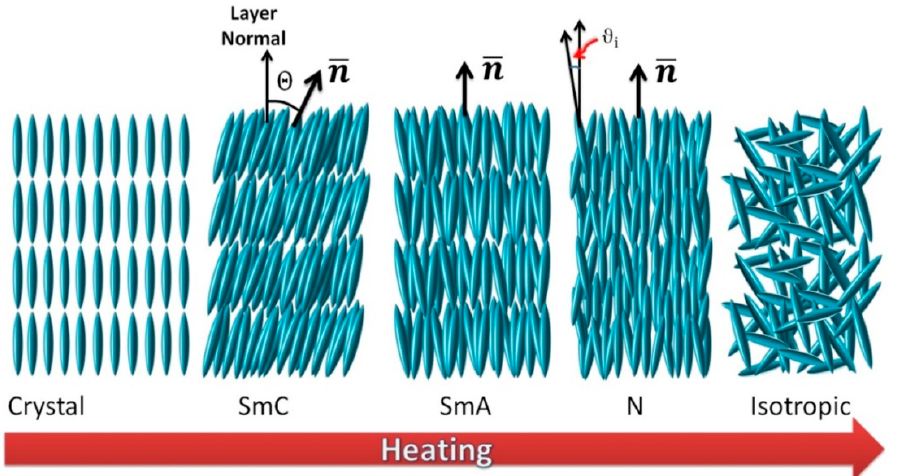
Figure 1. The molecular arrangement of crystal, liquid crystalline (SmC, SmA, and N) and isotropic phases. Reprinted/adapted with permission from Ref. [6]; published by MDPI AG, 2017.